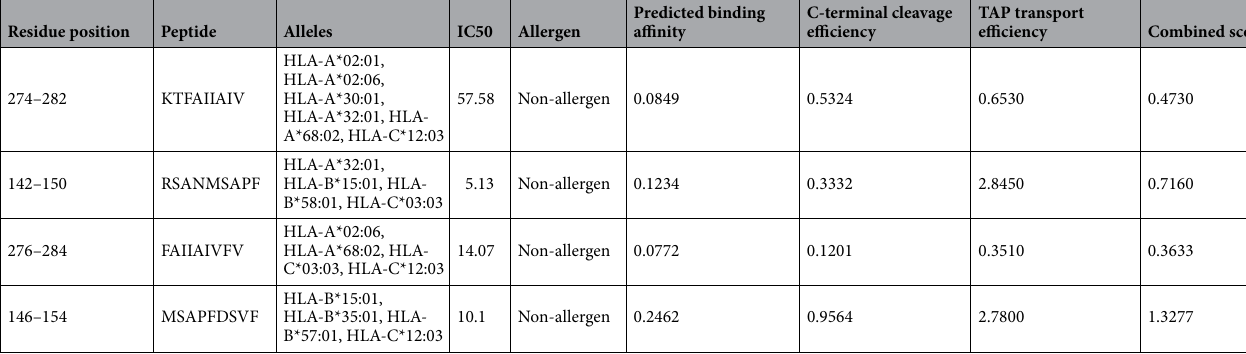
Table 3. MHC I associated peptides and alleles.